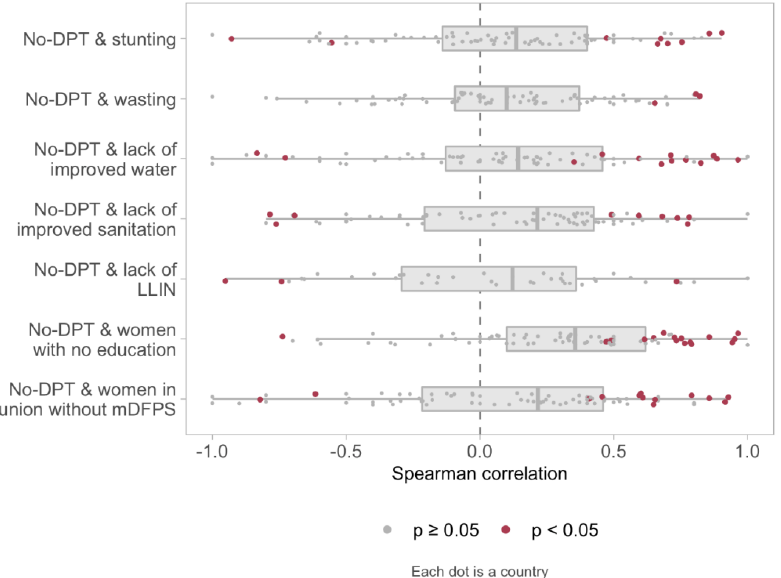
Figure 3. Distribution of correlation coefficients between no-DPT prevalence and deprivation indi- cators at country level in 80 countries (39 countries for bed nets). Each dot represents one country and red dots indicate PRs for which the 95% CI did not include the unity. Note: The extreme left of box represents the 25th percentile and the extreme right the 75th. The vertical line within the box represents the median. The whiskers extend to the largest or smallest value no further than 1.5 times the interquartile range. The medians and interquartile ranges are calculated with every country having the same weight. Legend: DPT: diphtheria, pertussis, tetanus. LLIN: long-lasting insecticidal nets. mDFPS: demand for family planning satisfied with modern methods.